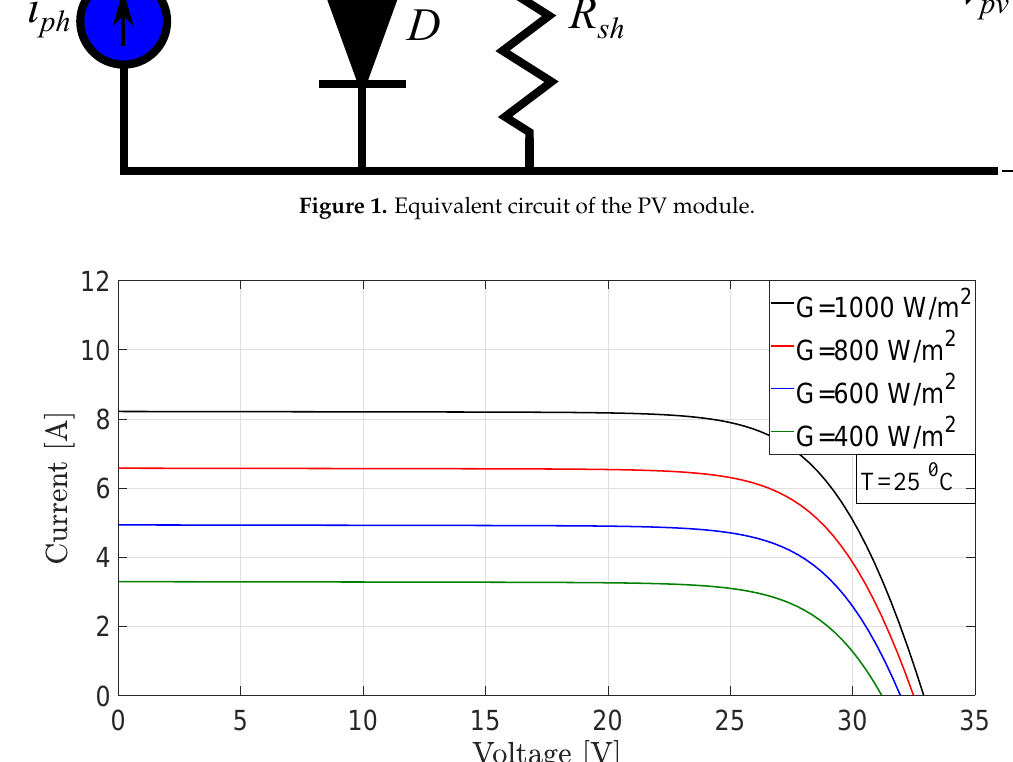
Figure 2. I–V characteristics of the PV source for various radiation